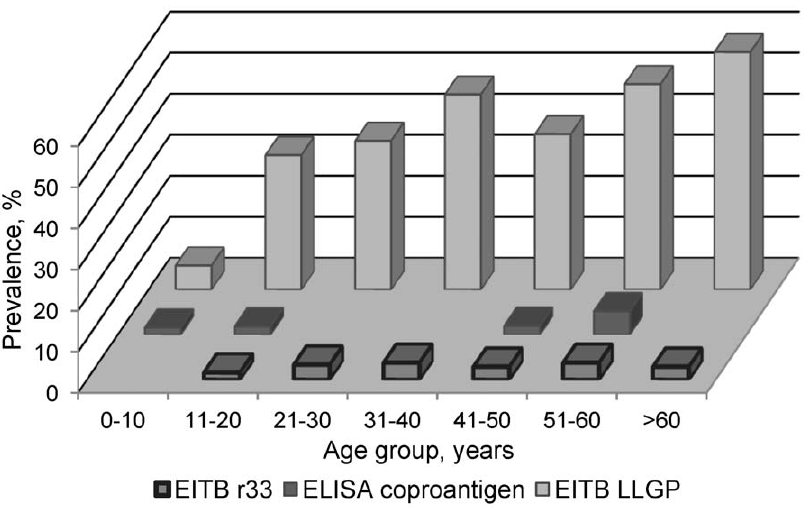
Figure 1. Relationship between age category and positive laboratory results for Taeniasolium infection in humans, Rica Playa, Tumbes,